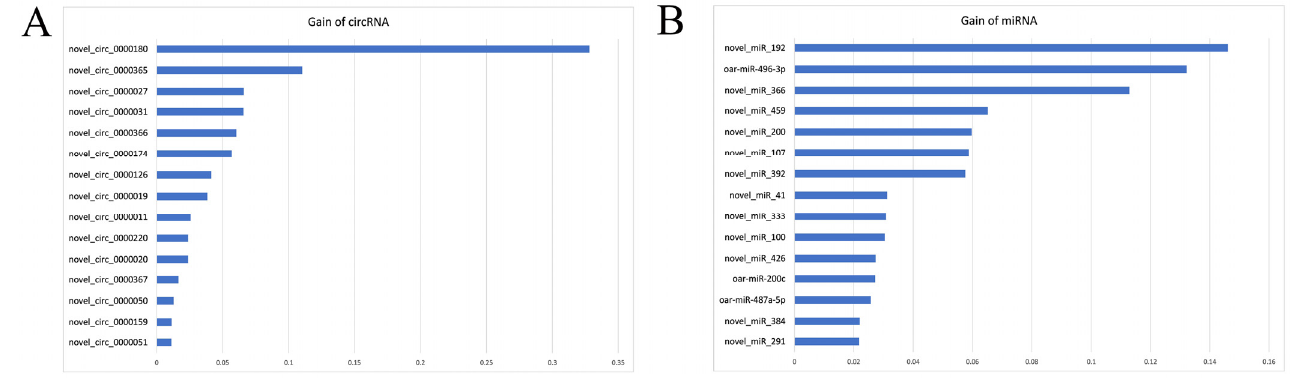
Figure 4. Gain value of top circRNAs ( A ) and miRNAs ( B ) selected by Random Forest-XGBoost.